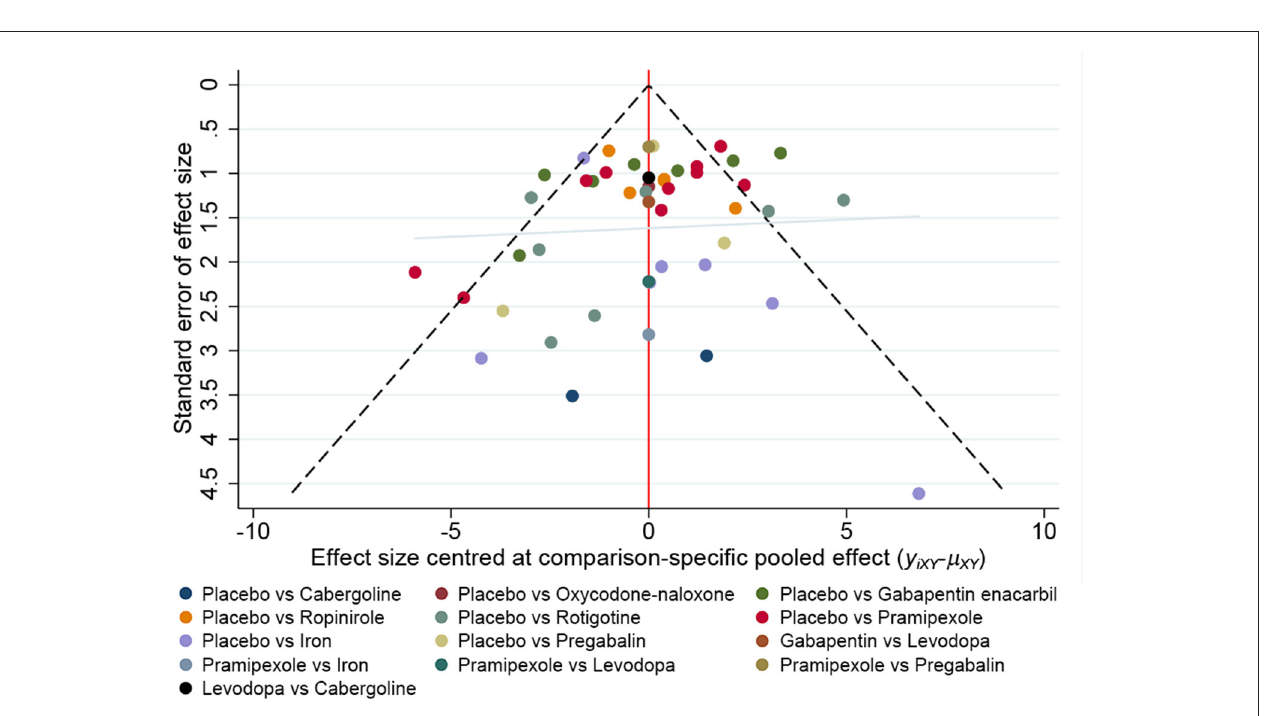
FIGURE 9 | A funnel plot to confirm the risk of publications bias for included